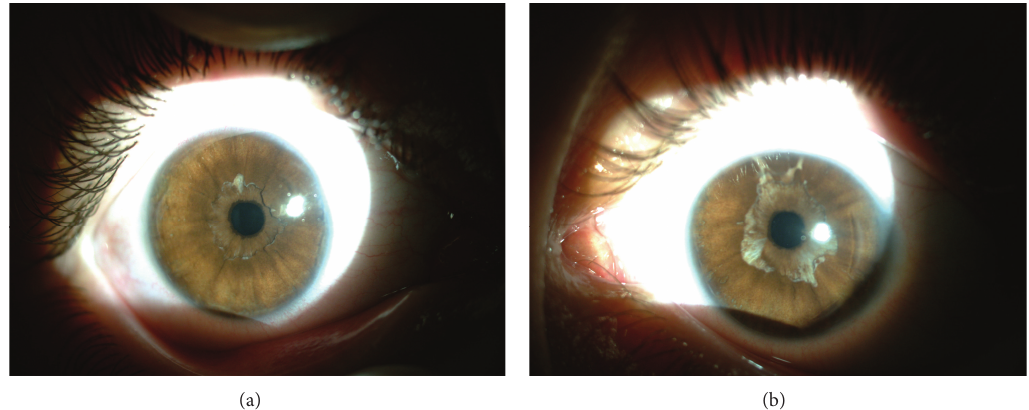
Figure 3: Postoperatively pupillary apertures were adequate and the sphincter muscles were intact and contracting in the right eye (a) and in the left eye (b).